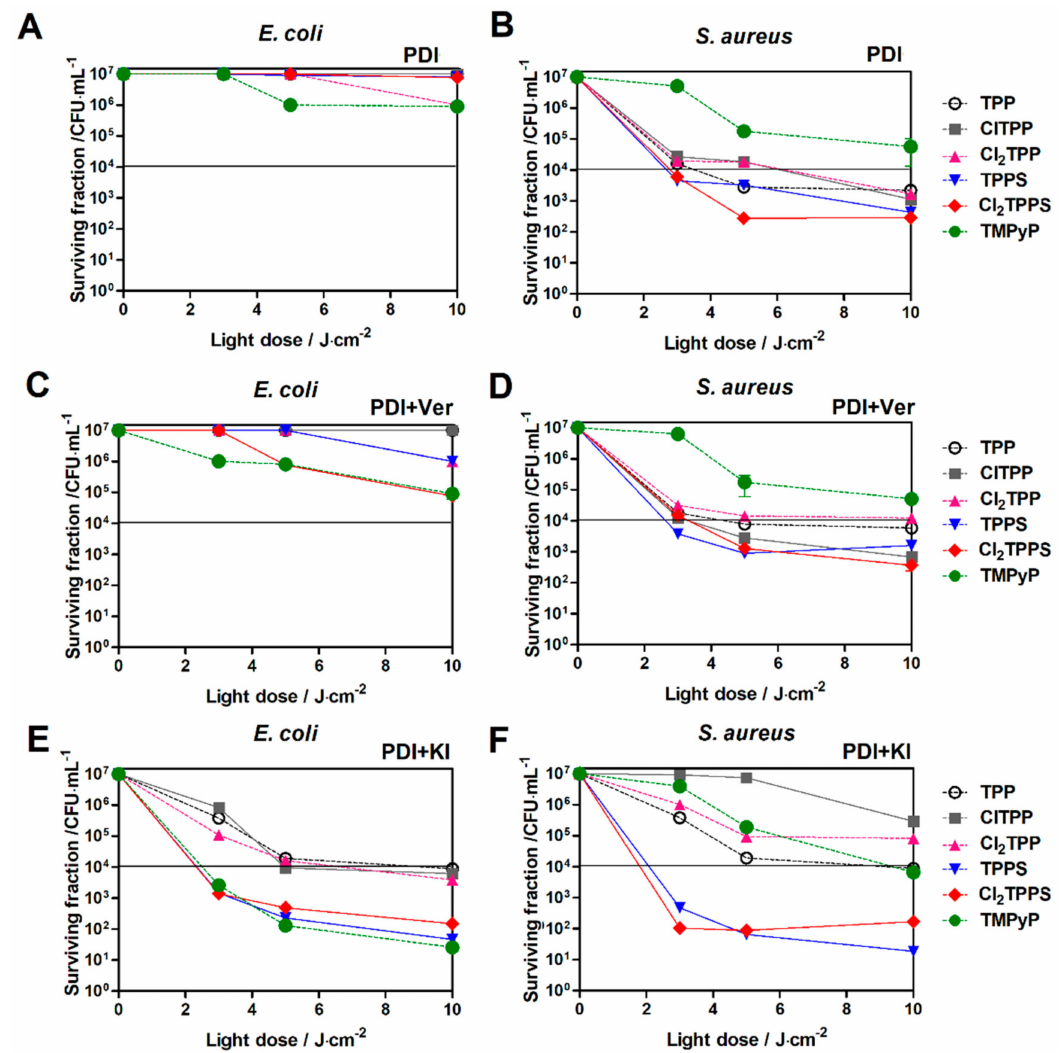
Figure 15. The surviving fraction of bacteria following PDI of E. coli and S. aureus with TPP, ClTPP, Cl 2 TPP, TPPS, Cl 2 TPPS, and TMPyP as the PS without ( A , D ) and with EPI ( B , E ) and KI addition ( C , F ) after 2 h of incubation with a low light dose up to 10 J / cm 2